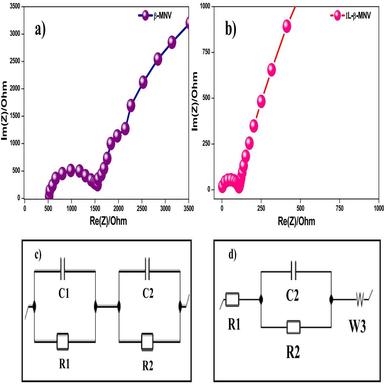
a) and b) are the Nquist plots of β-MNV and IL-β-MNV, respectively. c) and d) are the equivalent circuits for a) and b).